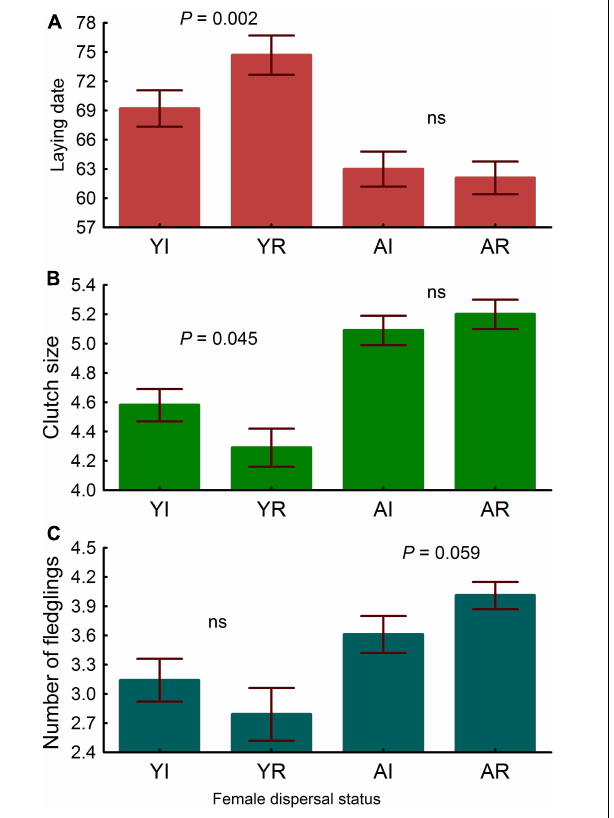
FIGURE 5 | Differences in laying date (A) , clutch size (B) and number of fledglings produced (C) in breeding common kestrel females. YI is young immigrant, YR is young resident, AI is adult immigrant and AR is adult resident. P -values correspond to post-hoc comparisons between groups from the interaction dispersal status × age in the LMMs. Values to the left and to the right correspond to differences in young and adults, respectively. “ns” means not significant differences (all P > 0.22). LMMs: laying date young females, estimate ± s.e . = -5.475 ± 1.69, t = 3.24; clutch size young females, estimate ± s.e. = 0.291 ± 0.14, t = 2.02; number of fledglings adult females, estimate ± s.e. = -0.407 ± 0.21, t = 1.90. Bars and whiskers represent mean and s.e. values,